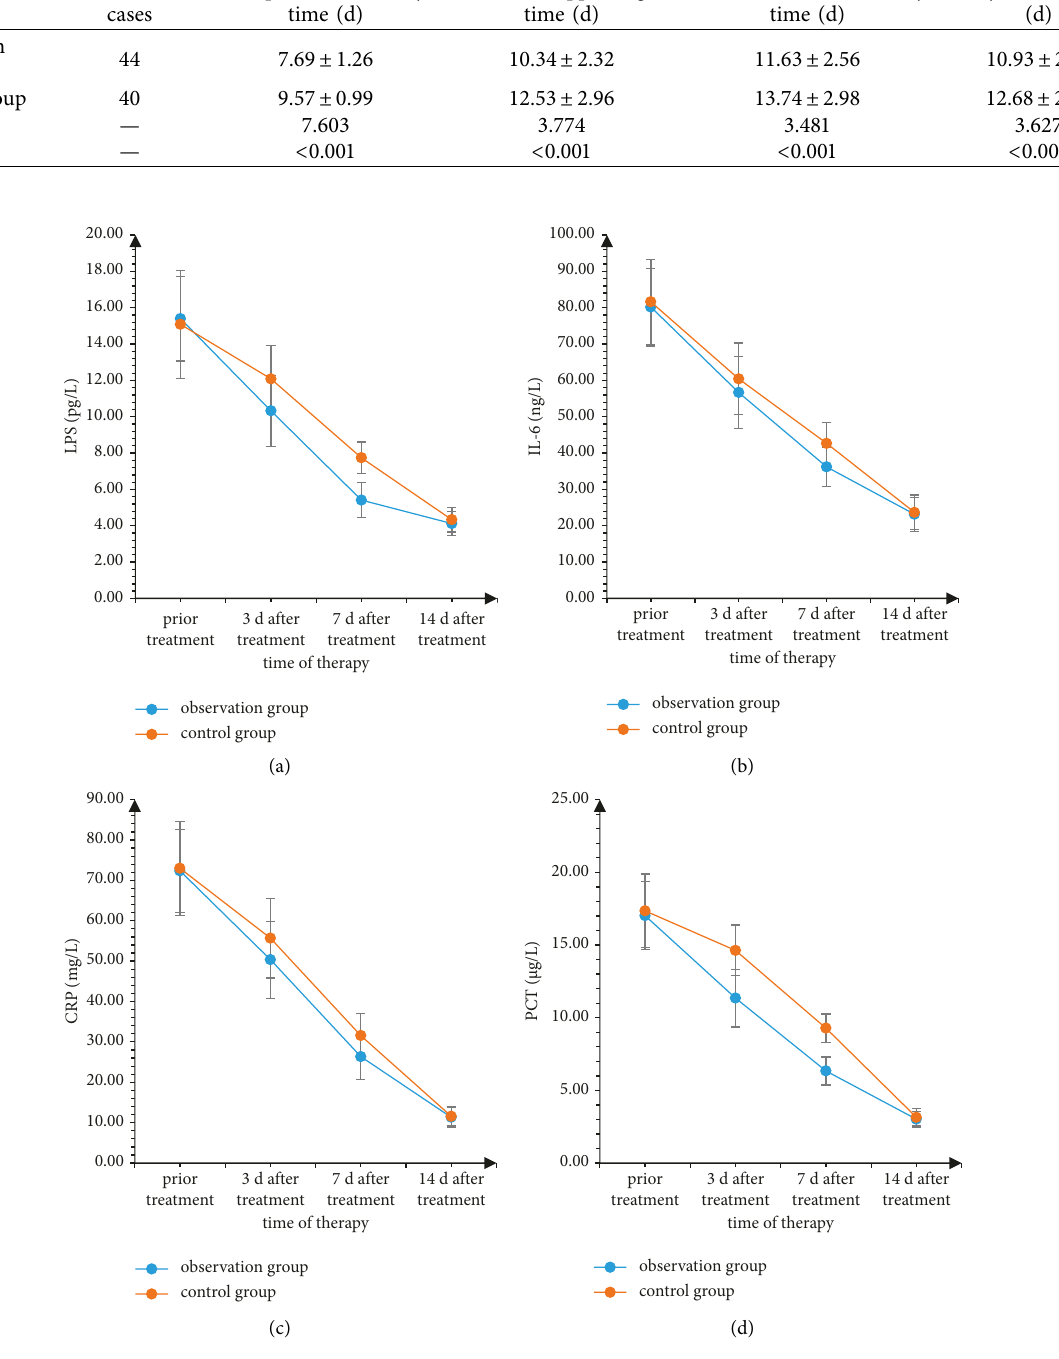
Figure 1: Comparison of serum infection indicators between the two groups of